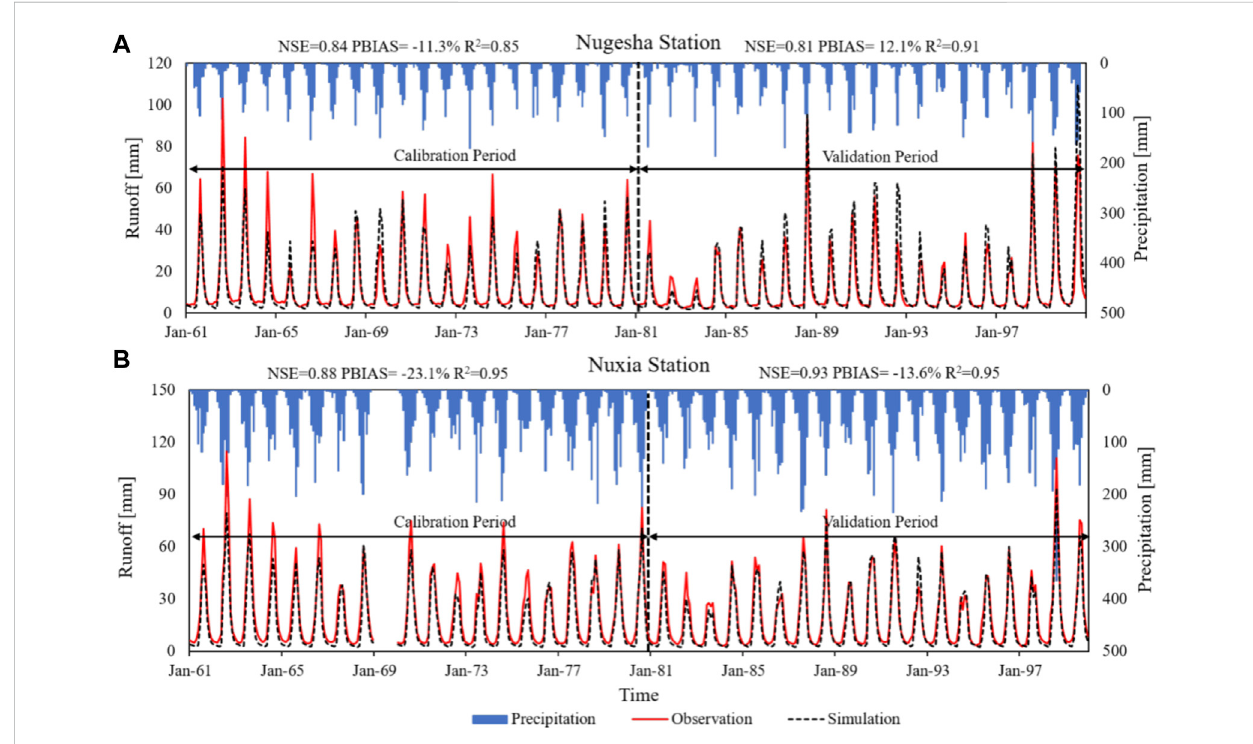
FIGURE 2 Calibration and validation of average monthly runoff [ (A) . Nugesha Station; (B) . Nuxia